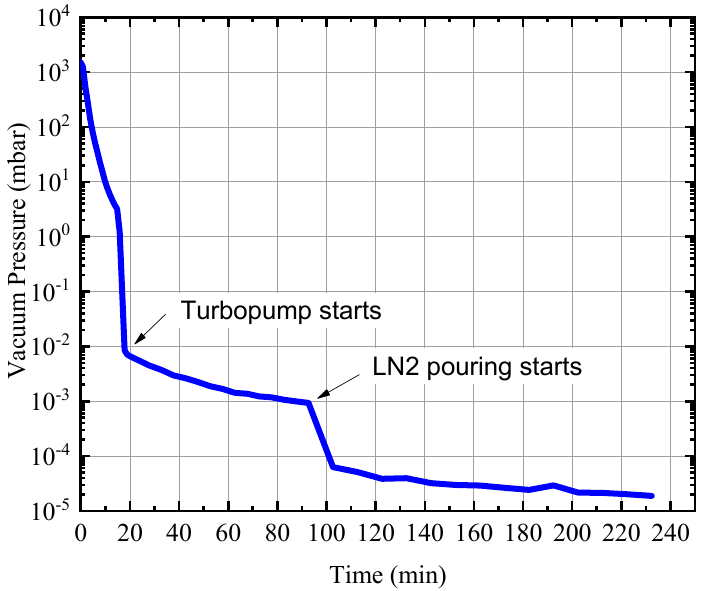
Figure 19. Air pressure inside the vacuum chamber versus time.